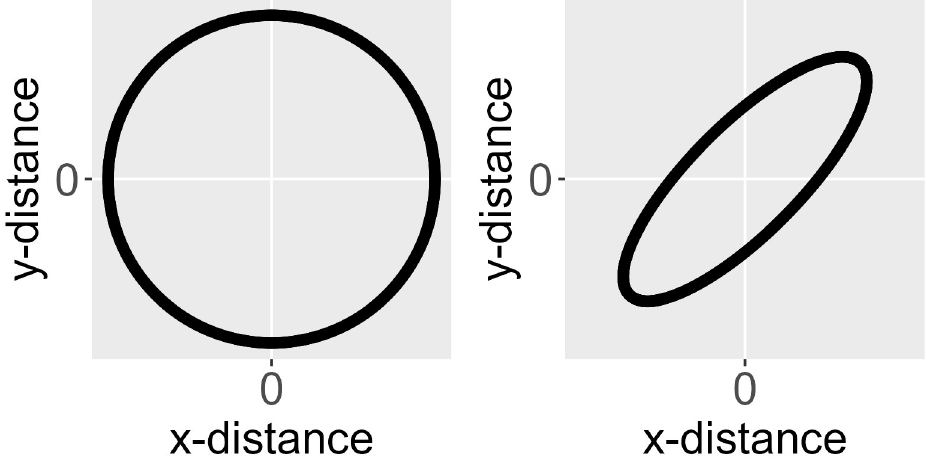
Fig 5. Ellipses for an isotropic and anisotropic covariancefunction centered at the origin. In A (left), the isotropic covariance function is visualized. In B (right), the anisotropic covariance function is visualized. The black outline of each ellipse is a level curve of equal